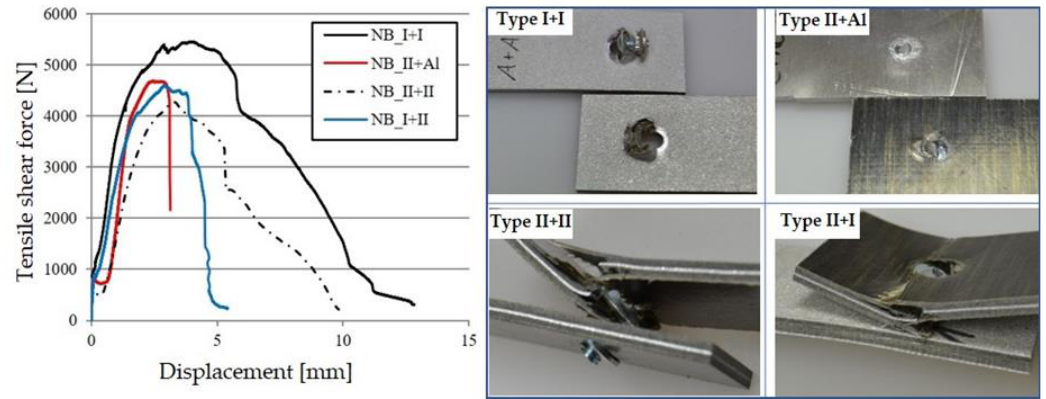
Figure 14. Tensile shear force and displacement curve with fractured joints after the tensile shear test of the nut and bolt joining process.